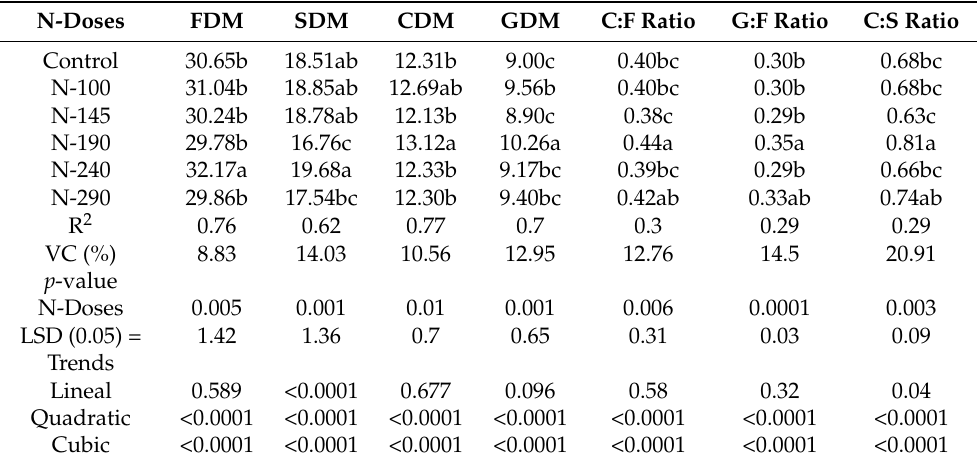
Table 4. Whole plant, cobs, and grain dry matter (DM) yields (t/ha).